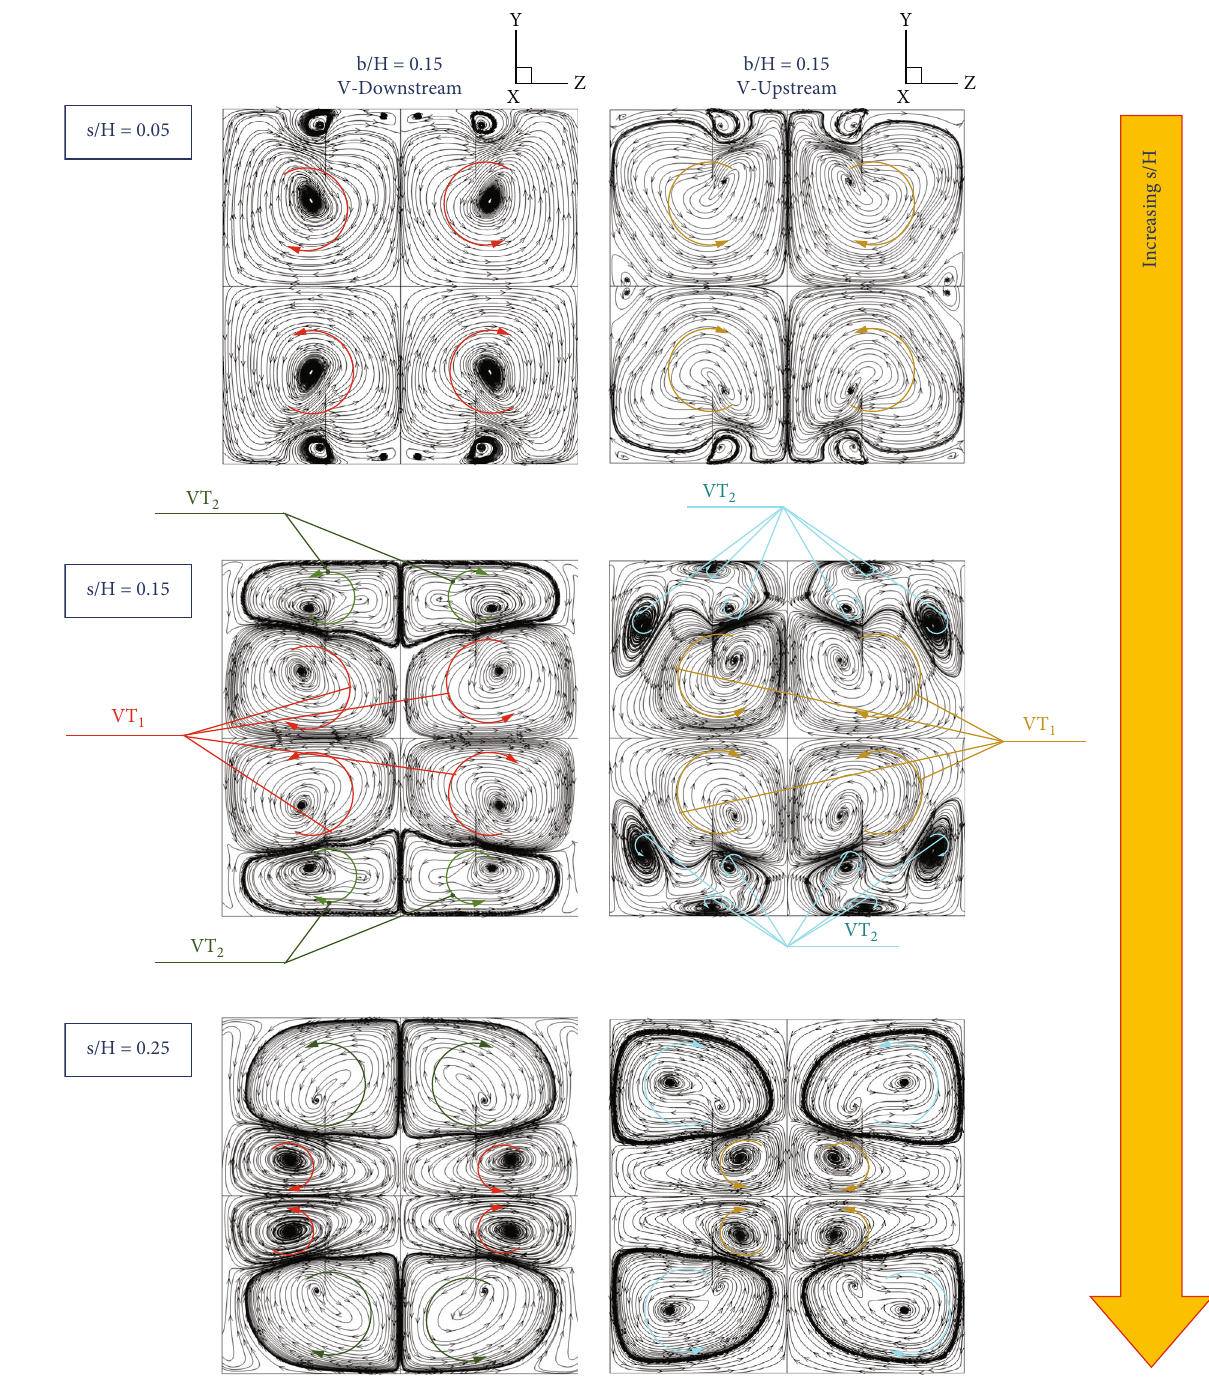
Figure 5: Flow structure at various